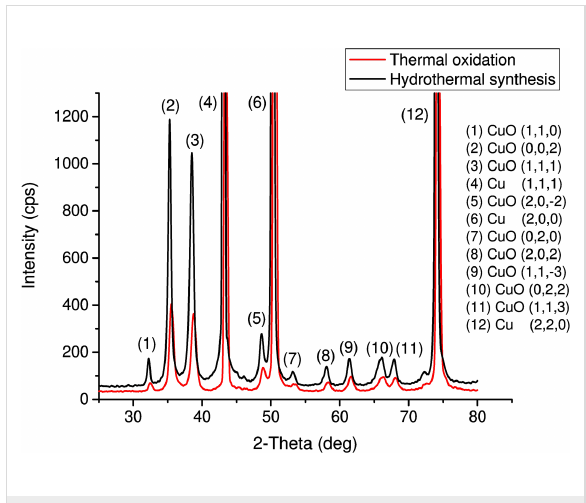
Figure 2: XRD pattern of CuO films. The red diffractogram corre- sponds to the sample obtained by thermal oxidation and the black diffractogram corresponds to the sample obtained by chemical hydro- thermal